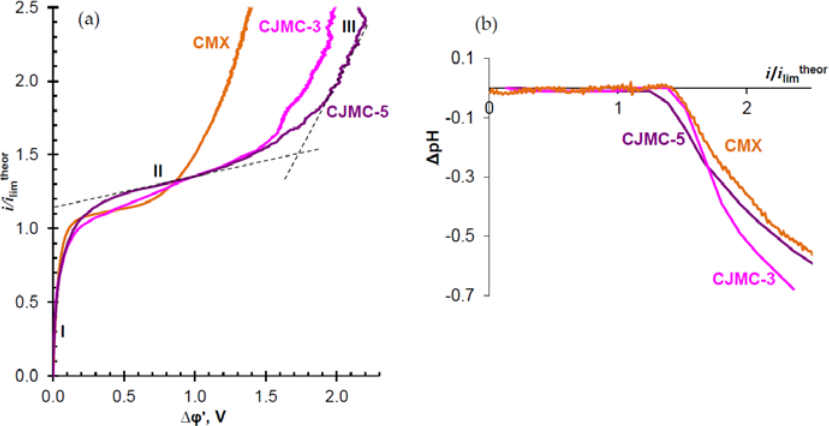
Figure 7. Current–voltage curves (CVCs) of the studied membranes (surface I) ( a ) and differences between the outlet and inlet pH of the NaCl solution passing through the desalination compartment ( b ). The desalination channel is formed by one of the CEMs under study and a MA-41 anion-exchange membrane. The concentration of the solution at the inlet of the DC and other channels of the electrodialysis cell is 0.02 eq L − 1